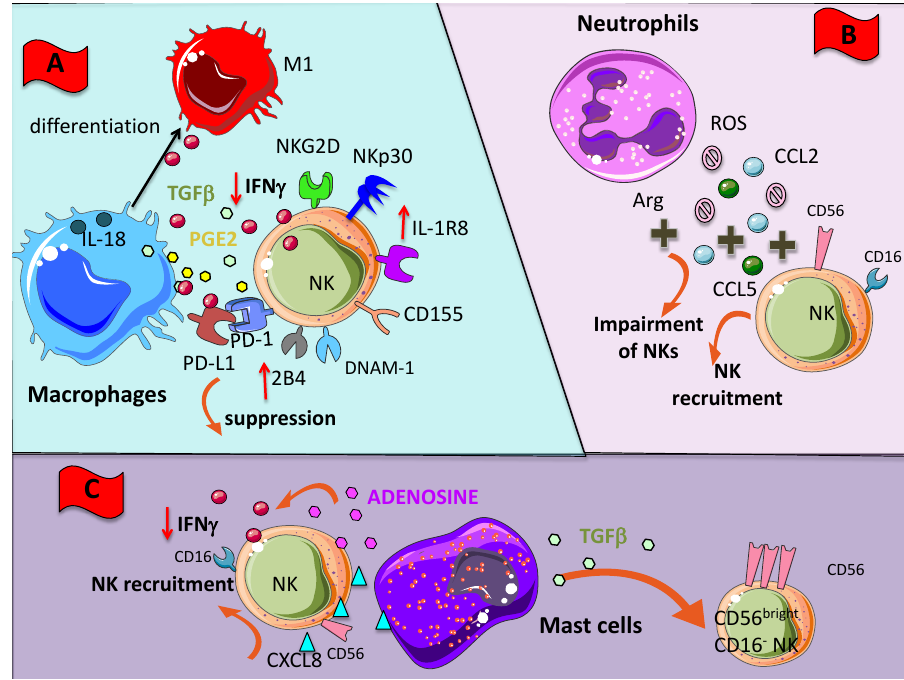
Figure 2. NK cross-talk with innate immunity cellular components of TME. Within TME, NK cells can encounter different cells such as macrophages ( A ), neutrophils ( B ), and mast cells ( C ). All these cells have been shaped by the TME to exert an inhibitory effect on NK cells through the direct cell-to cell interaction or the soluble factors listed in Figure 1. ( A ) M2-like macrophages can deliver negative signals to NK cells by the release of TGF- β and PGE 2 but also by the binding of PD-L1 to PD1; these interactions lead to downregulation of several NK cell activating receptors, such as NKG2D, NCR and DNAM1. ( B ) Neutrophils can impair NK cell functions via reactive oxigen species (ROS) and arginase (Arg) activity; they also secrete CCL2 and CCL5 chemokine favoring NK cell tissue localization; in turn, NK cells release CXCL8 which attract to the tumor site other neutrophils amplifying the